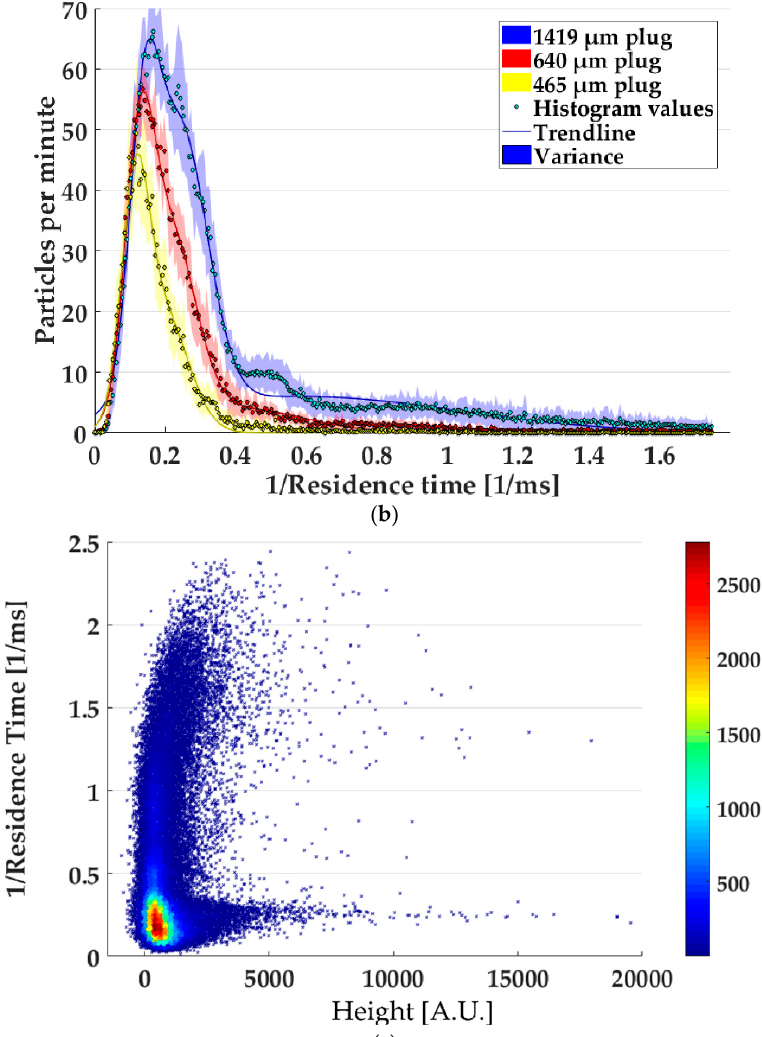
Figure 3. ( a ) Histograms of the fluorescence intensity of different experiments. ( b ) Histograms of the reciprocal residence time of different experiments. ( c ) Heatmap for all particles of a 1419 μ m plug experiment to detect correlations between fluorescence intensity and residence time (colored areas in ( a ) and ( b ) represent the variance of three to four repeated experiments under the same conditions).